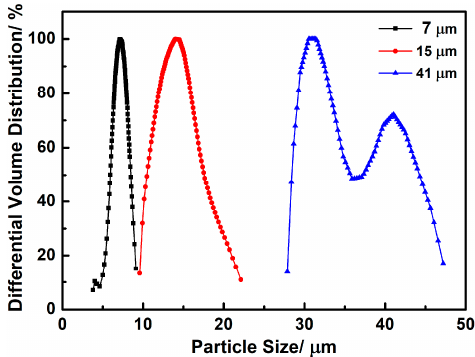
Figure 1. Particle size distribution curves of ~7, ~15, and ~41 μ m α -SiC powders.